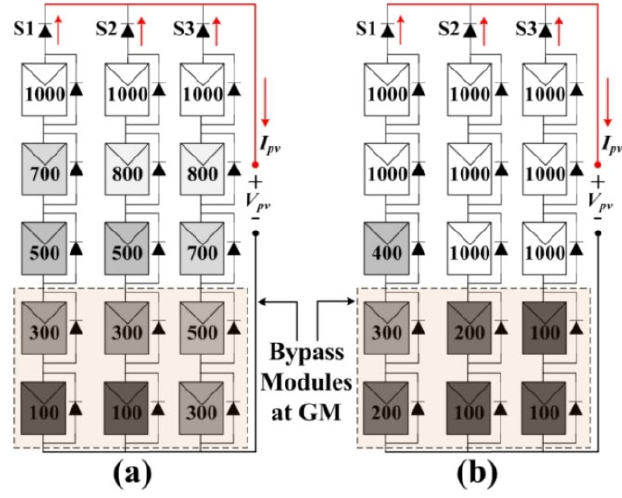
Figure 11. PV array with two different shading patterns.